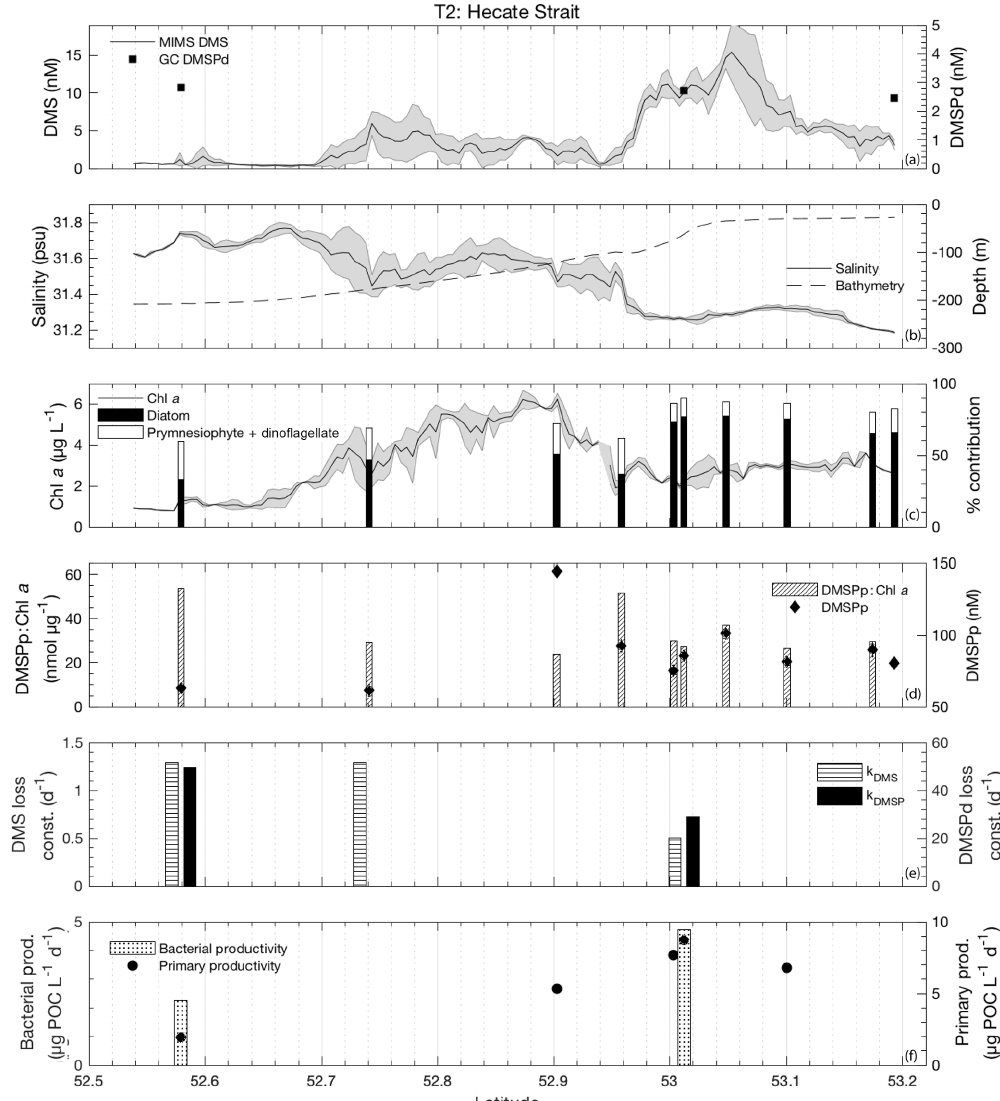
Figure 6. The same as Fig. 4 but for the T2